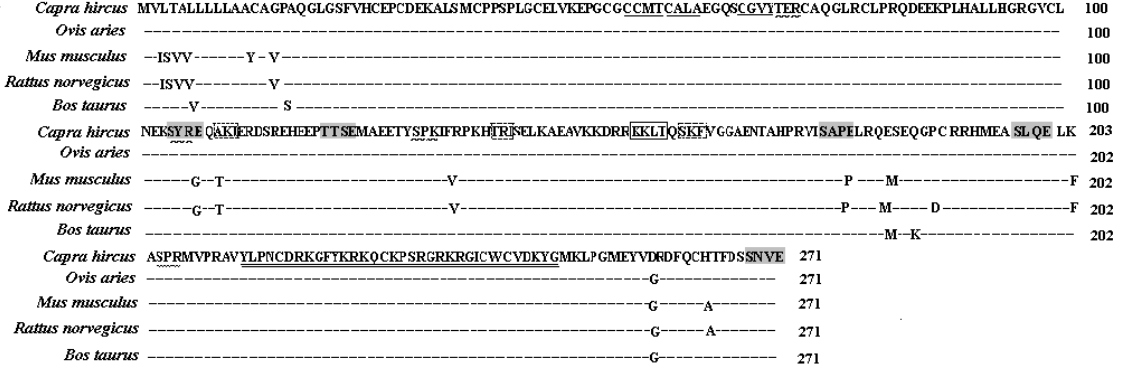
Figure 3. Predicted P sites of IGFBP-5 . Alignment of the amino acids sequences of Capra hircus (JF720883), Ovis aries (EU727460), Mus musculus (BC057447), Rattus norvegicus (NM_012817) and Bos taurus (NM_001105327). cAMP- and cGMP-dependent protein kinase phosphorylation sites are marked by a box. Protein kinase C phosphorylation sites are marked by a wavy line. Casein kinase II phosphorylation sites are marked by a gray box. Prenyl group binding sites (CaaX box) are marked by underlining. Thyroglobulin type-1 repeat signature is marked by double underlines. Microbody C-terminal targeting signals are marked by a hidden line frame. All these were determined using the Psite program (http://www.softberry.com).